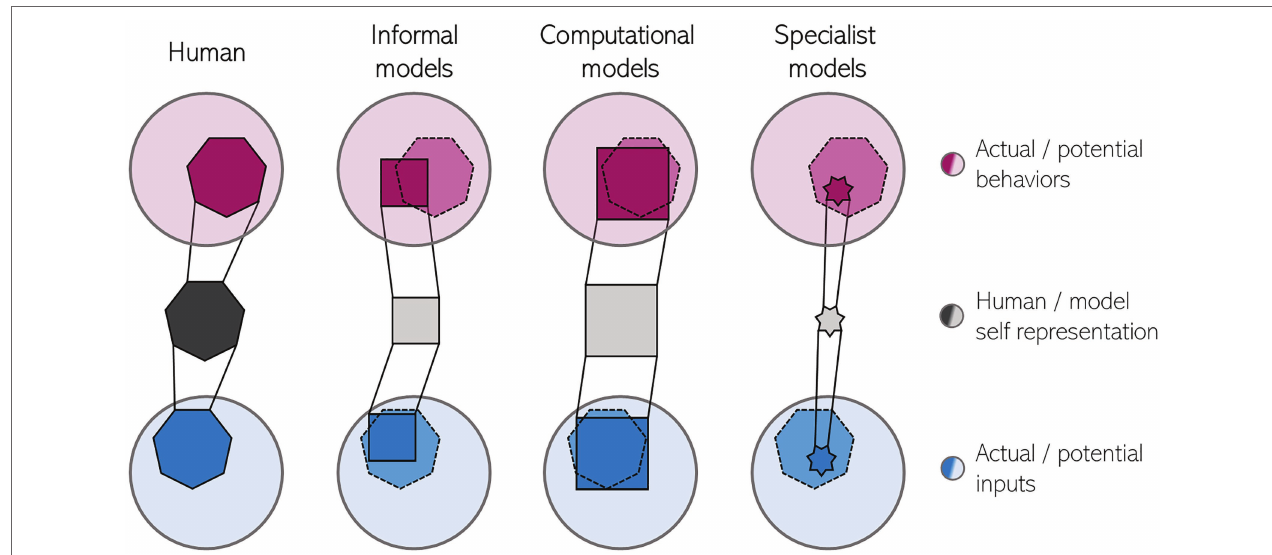
FIGURE 1 | Schematic of the representational power of models for the human minimal self. The human minimal self representation (dark grey, left) is based on a relevant subset of all self-related information (blue) while also underlying a subset of all possible self-related behaviors (purple, e.g., experiencing a piece of furniture as belonging to oneself). Currently, models of the self (right) are too narrow in the sense that they consider only a subset of potential inputs and in practice can generate only a small subset of human behaviors and/or too general in the sense that they make too unspecific predictions regarding self-related phenomena, violating the bounds of the human self (dotted line). Note, that the relative number of constraints underlying each self-representation is reflected by the number of sides of the respective